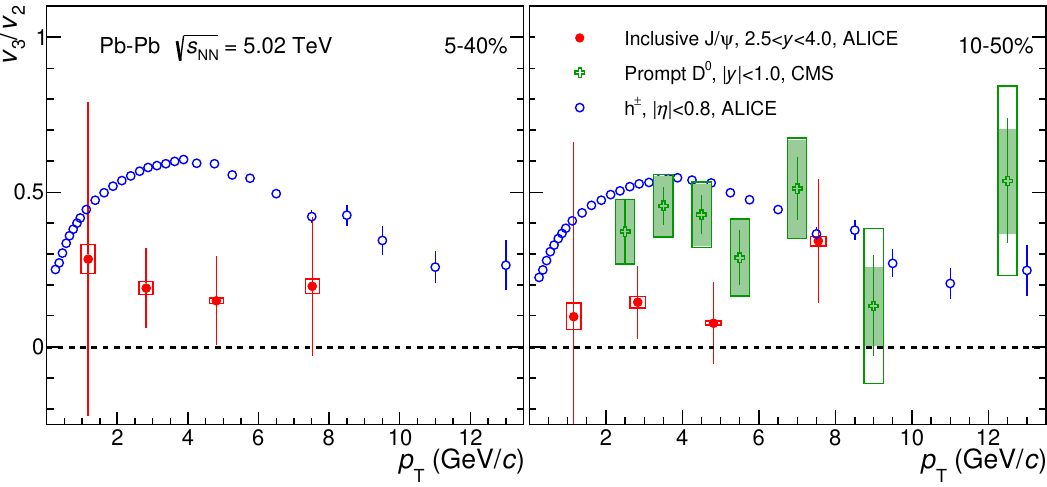
Figure 6 . (Color online) The J/ v 3 / v 2 ratio as a function of p T in the 5{40% (left panel) and p 10{50% (right panel) centrality intervals in Pb-Pb collisions at s NN = 5.02 TeV. The results are compared to those of mid-rapidity charged particles [50] and prompt D 0 mesons [23]. Statistical and systematic uncertainties are shown as bars and boxes, respectively. The shaded bands represent the systematic uncertainties from the contribution of non-prompt D 0